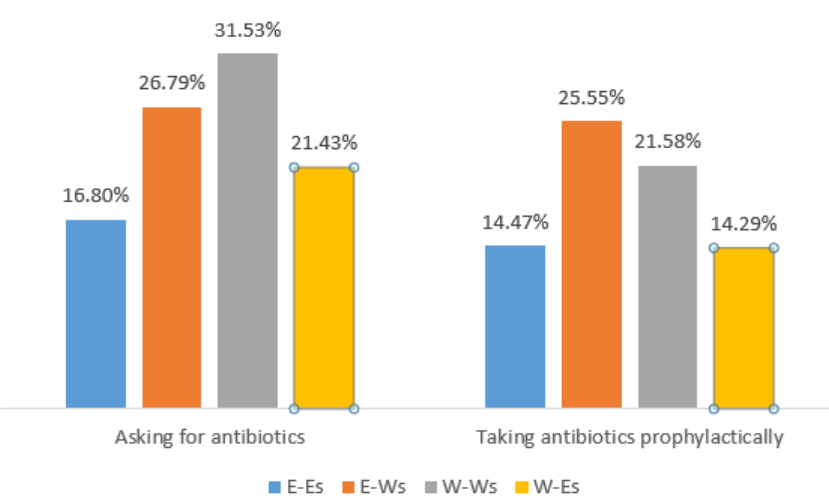
Figure 2. Descriptive statistics of antibiotic use behaviors among university students by groups.